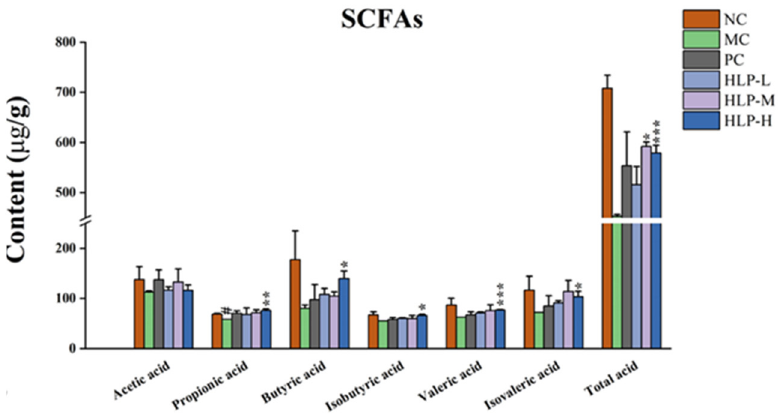
Figure 4. Short-chain fatty acids (SCFAs) content in mice. # p < 0.05 vs. NC group; * p < 0.05, ** p < 0.01, *** p < 0.001 vs. MC group. NC: normal control group, MC: model control group, PC: positive control group, HLP-L: low-dosage HLP group, HLP-M: middle-dosage HLP group, and HLP-H: high-dosage HLP group.